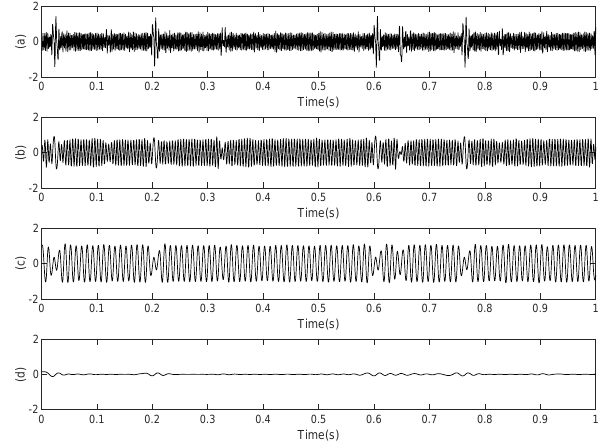
Figure 6. The IMF components 1–4 ( a – d ) of the mixed signal after EMD.